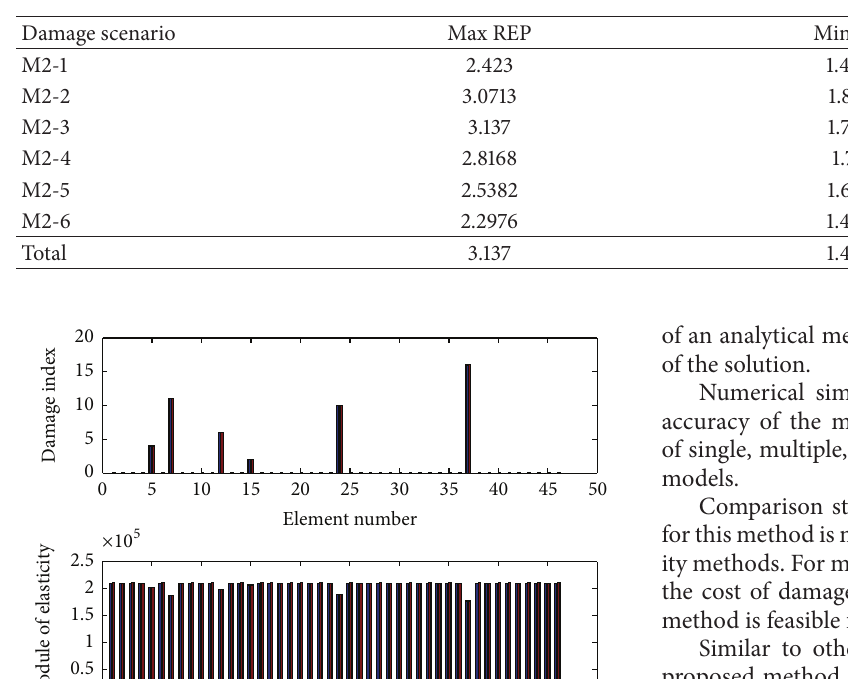
Table 8: REP ranges in different scenarios for model 2.